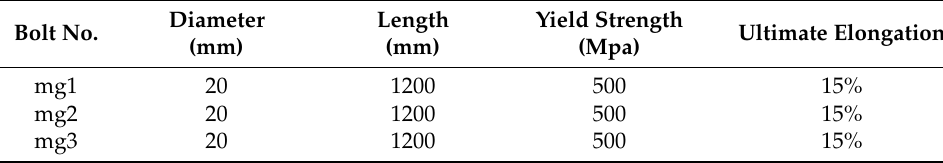
Figure 3. Test bolts. Table 1. Bolt test parameters.